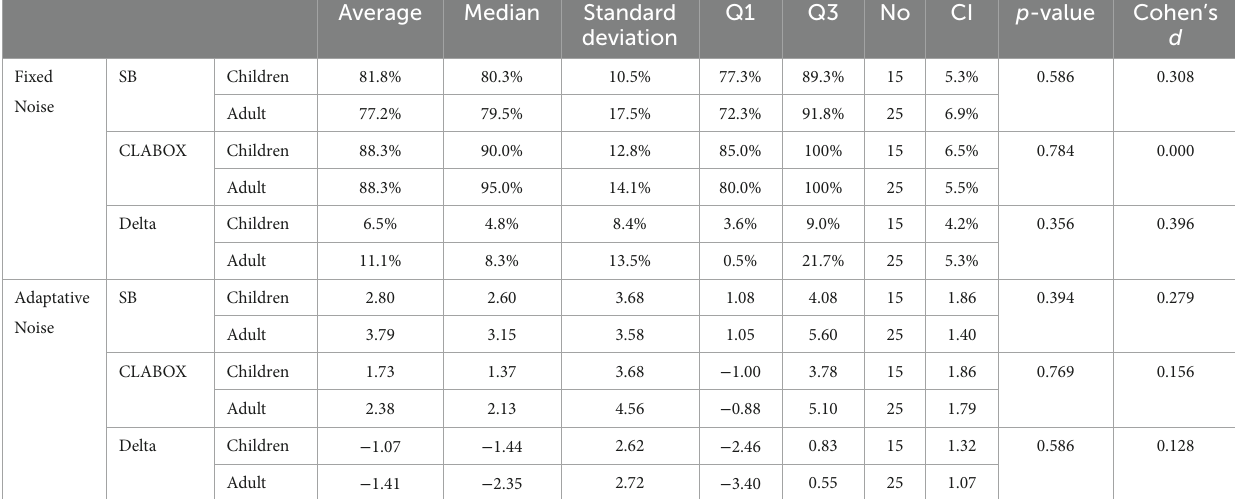
TABLE 1 Comparison of SB and CLABOX in the groups of children and adults in the speech perception test - HINT.